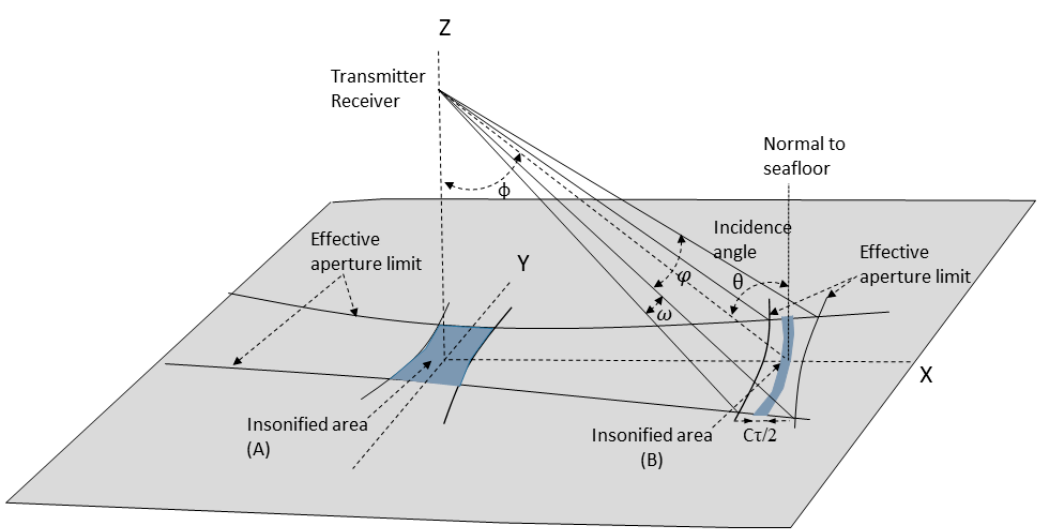
Figure 1. Measurement geometry of MBES and an insonified area for near-nadir ( A ) and at an oblique angle ( B ). Figure modified from Malik et al. 2018.